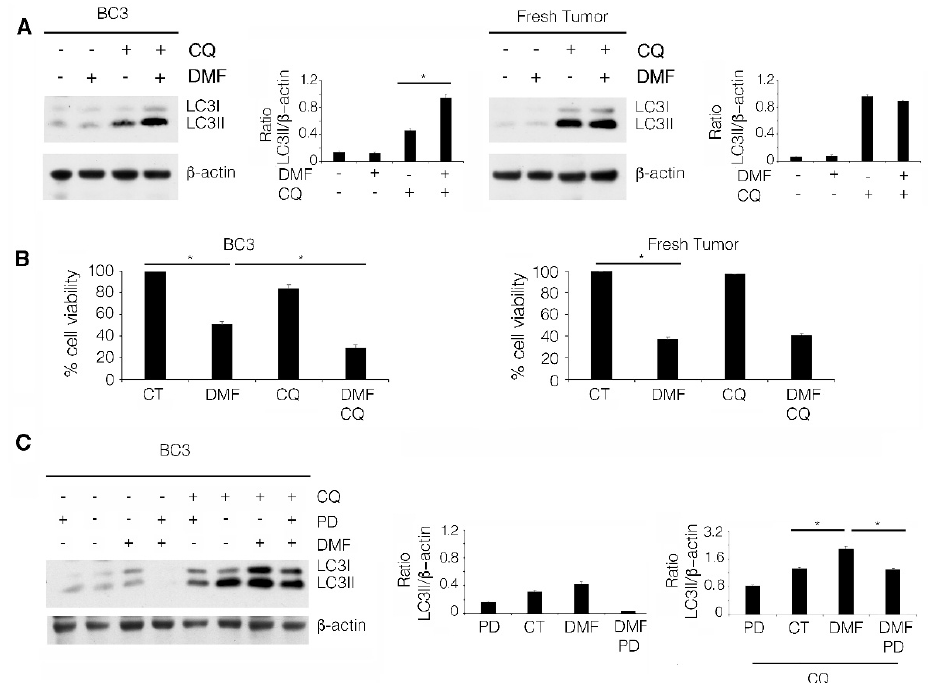
Figure 4. ERK1/2 activation triggers a pro-survival autophagy, reducing the DMF cytotoxicity in the BC3 cell line. ( A ) Western blot analysis to detect LC3II levels in BC3 cells and PEL fresh tumors, treated or not (CT) with 50 µ M DMF for 24 h, in the presence of 20 µ M chloroquine (CQ). β -actin was used as loading control, and one representative experiment out of three is shown. The histograms represent the mean plus SD of the densitometric analysis of the LC3II/ β -actin ratio of three different experiments. ( B ) Percentage of cell viability of BC3 cells and PEL fresh tumors, treated or not (CT) with 50 µ M DMF for 24 h, in the presence or absence of 20 µ M CQ. ( C ) Western blot analysis to detect LC3II levels in BC3 cells, treated or not (CT) with 50 mM DMF for 24 h, in the presence or absence of 20 µ M chloroquine (CQ) and PD98059 EK1/2 (PD) inhibitor. β -actin was used as loading control, and one representative experiment out of three is shown. The histograms represent the mean plus SD of the densitometric analysis of the LC3II/ β -actin ratio of three different experiments. In the figure, mean ± standard deviation (SD) of three independent experiments is shown. * p <